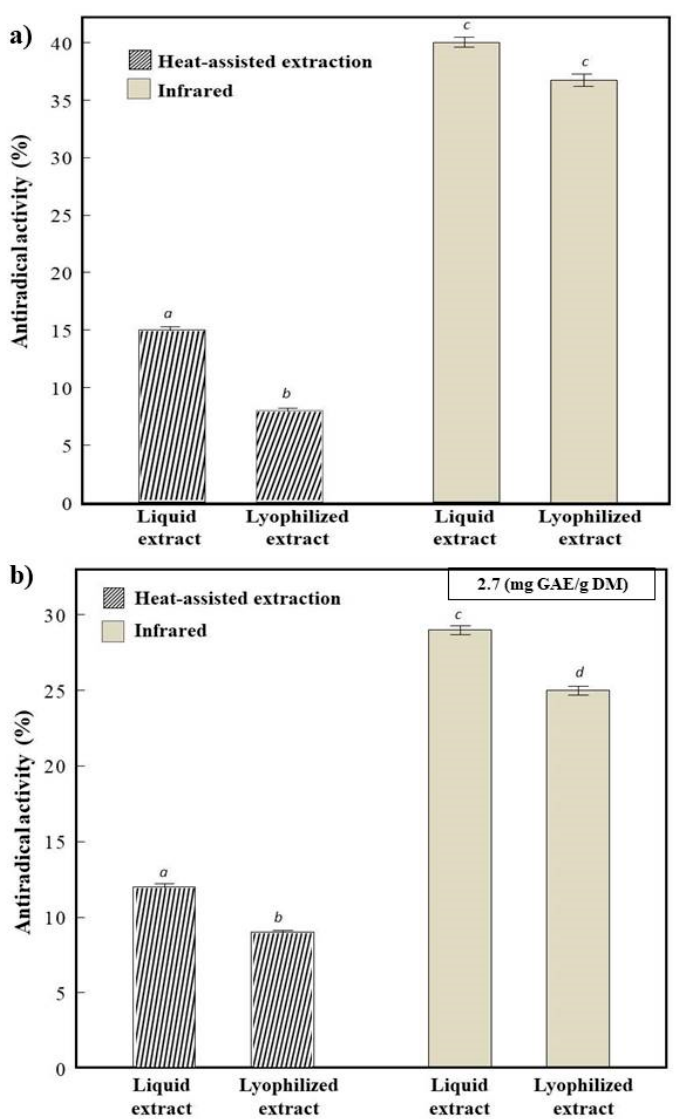
Figure 2. Antiradical activity of heat-assisted extraction and infrared apricot pomace extracts (liquid and lyophilized). ( a ) at their initial concentration and ( b ) at 2.7 mg GAE/g DM of polyphenols. Different superscript letters indicate significant statistical difference ( p < 0.05).